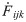
The simple quadrupedal model used in this paper.Two point masses sit on massless legs that can extend and contract. The point masses are connected with a rigid trunk. Five morphological parameters are inputs: the mass of the fore and hindquarters (mF and mH, respectively), the trunk length (lB), and the maximum length of the fore and hindlimbs (lFmax and lHmax, respectively). Two kinematic variables are also used as inputs: the stride length (D) and the average horizontal speed (U). From these seven constant inputs, trajectory optimization determines footfall positions (fijk, where i, j and k refer to Fore-Hind, Right-Left and {Trailing contact}-{Leading contact}, respectively) and over twenty temporal variables, including ground reaction forces and their rate of change (Fijk and F˙ijk), center of mass position and velocity (x and x˙) and body pitch angle and angular velocity (θ and θ˙). rF and rH are the displacement vectors from the COM to forequarters or hindquarters, respectively. Other notation conventions are described in Table 1.